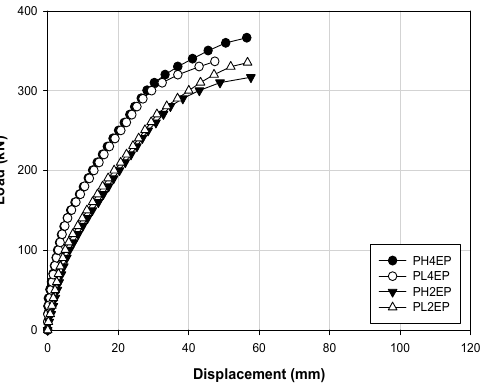
Figure 7. Load–displacement responses for materials with different concrete strengths.